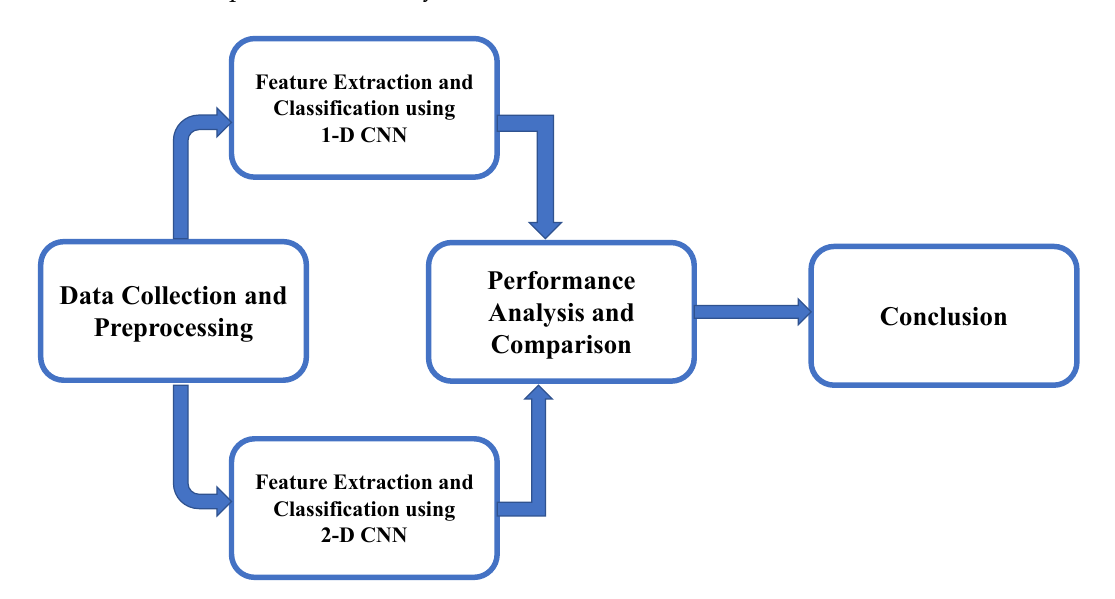
Figure 3. Methodology implemented.